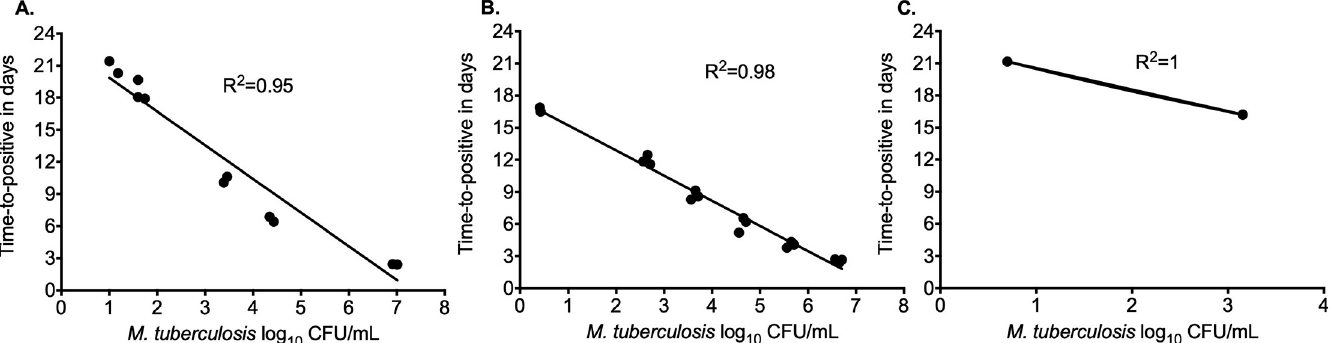
Fig 2. Correlation between the time-to-positive from MGIT and the CFU/mL. As shown by the R 2 , there was a good correlation between the M . tuberculosis bacterial burden recoded using the solid agar methods with the MGIT obtained time-to-positive for the (A) log phase growth, (B) semi-dormant bacilli, and (C) anaerobic cultures. However, the limit of detection was different between the metabolic